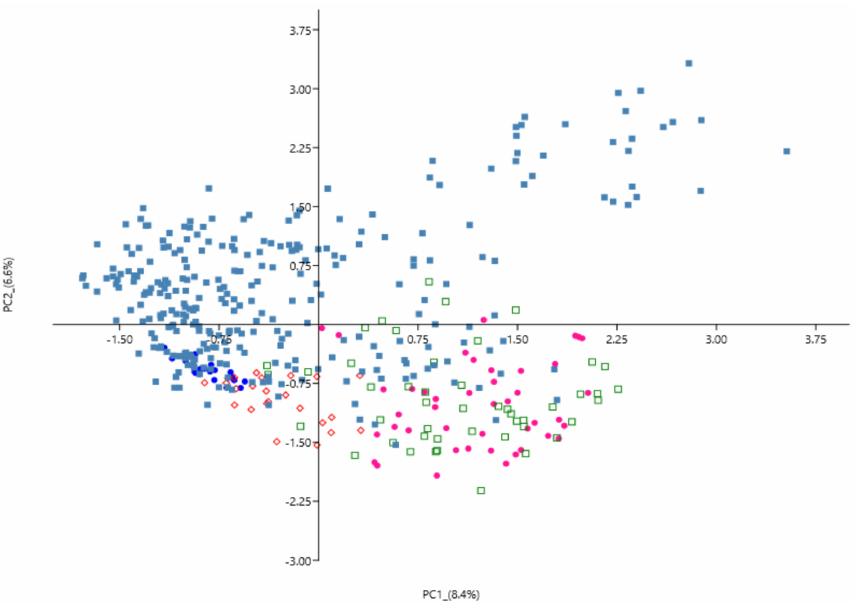
Figure 3. Principal components (PC) analysis for the genetic differentiations among sheep breeds using PC1 and PC2. Barbaresca (BARB · ), Comisana (COM · ), Pinzirita (PIN (cid:3) ), Sarda (SAR (cid:5) ), and Valle del Bel ì ce (VDB (cid:4) ).